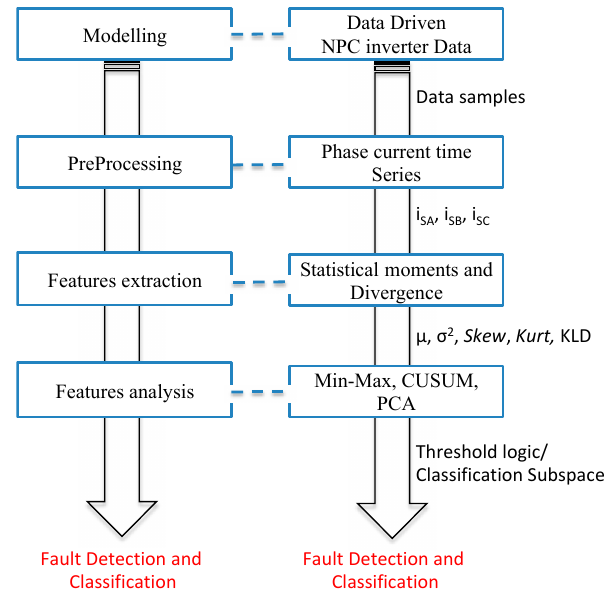
Figure 5. Flowchart for the methodology and its application in our work.